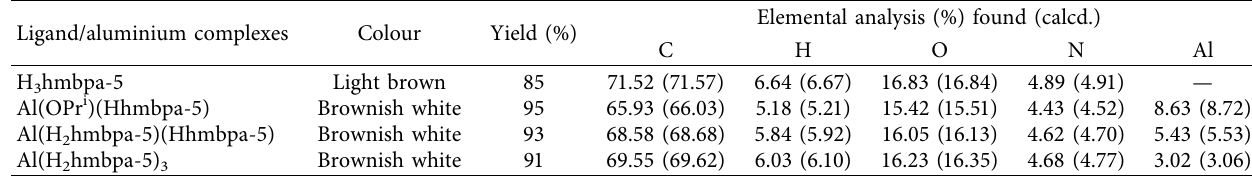
Table 1: Analytical data of synthesized ligand ( 1 ) and aluminium complexes ( 1a–1c ). Ligand/aluminium